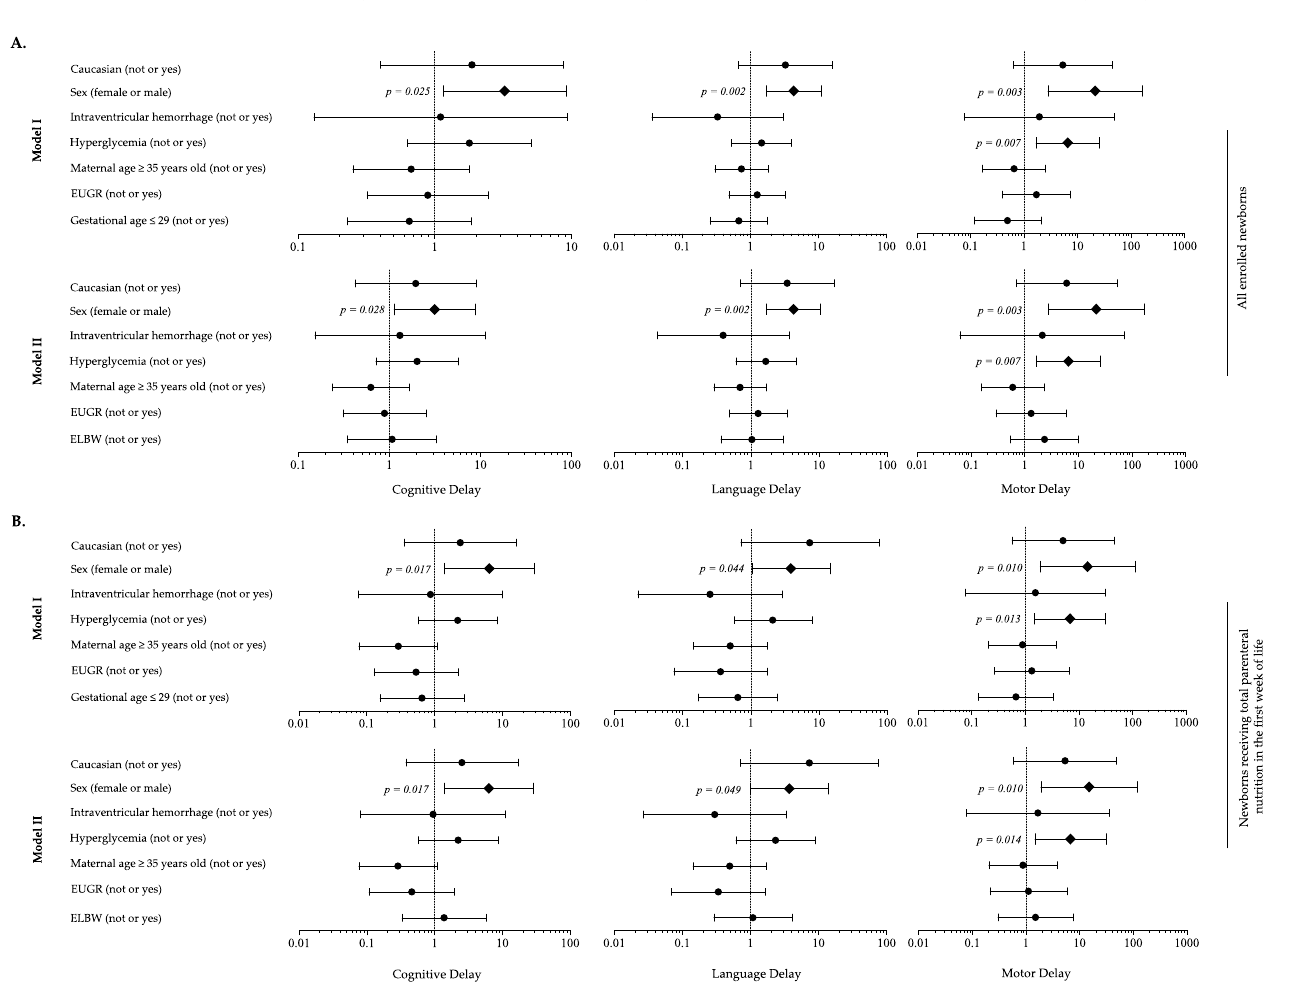
Figure 6. Multivariate analysis to evaluate the influence of covariates on the occurrence of neurodevelopment delay in each domain of Bayley Scales of Infants Development at 24 months of life. ( A ) All enrolled newborns; ( B ) Newborns receiving total parenteral nutrition in the first week of life. Figure legend: EUGR (extrauterine growth retardation); ELBW (extremely low birth weight infants).